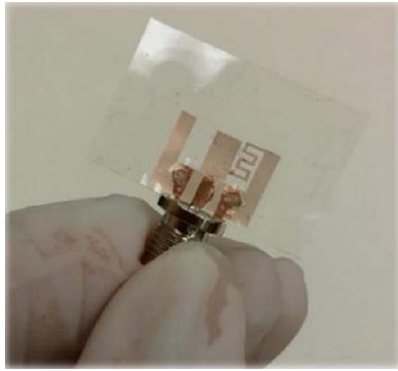
Figure 14. The photo of the mechanically reconfigurable electrically small antenna in [106]. The antenna made of flexible wire mesh and a frequency shift is generated in different stretch.